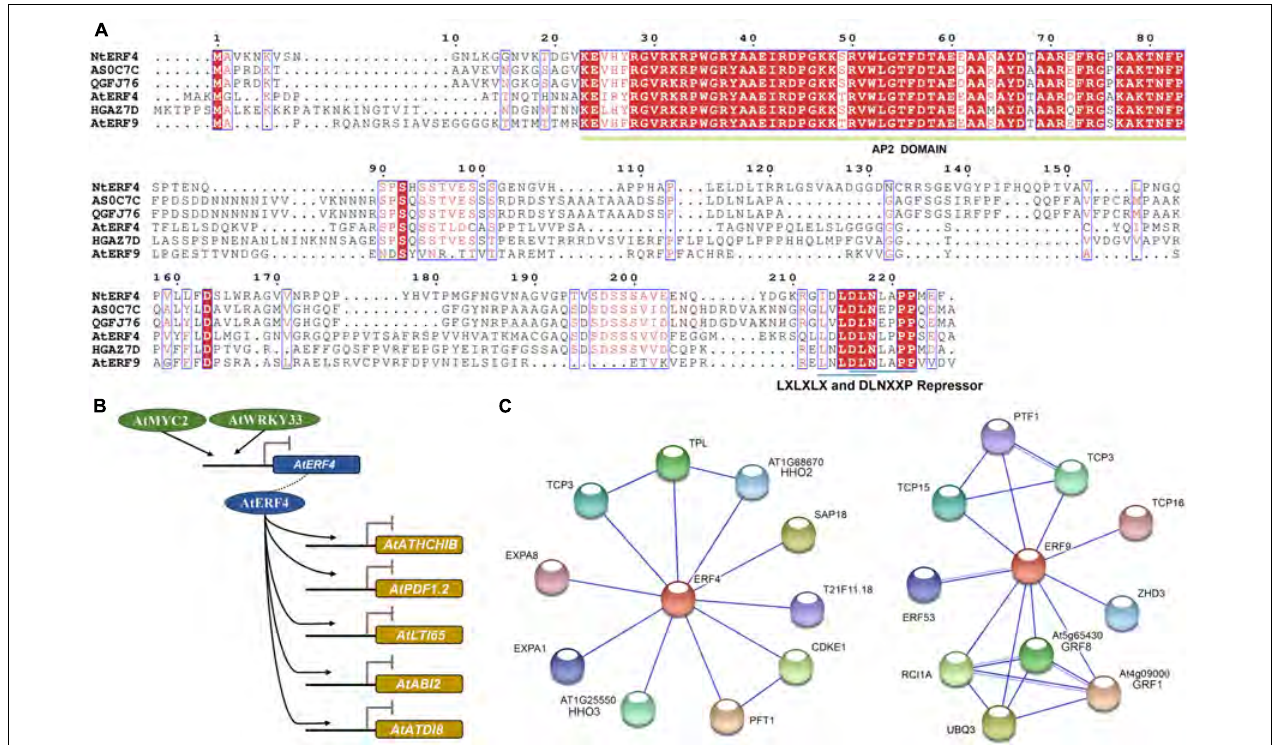
FIGURE 10 | Protein sequence alignment, target genes, and interaction network analysis of key AP2/ERFs according to A. thaliana homologs. (A) Protein sequence alignment of AtERF4, AtERF9, NtERF4, Arahy.AS0C7C, Arahy.QGFJ76, and Arahy.HGAZ7D; (B) Target genes of Arabidopsis homologs; (C) Interaction network relationships of Arabidopsis